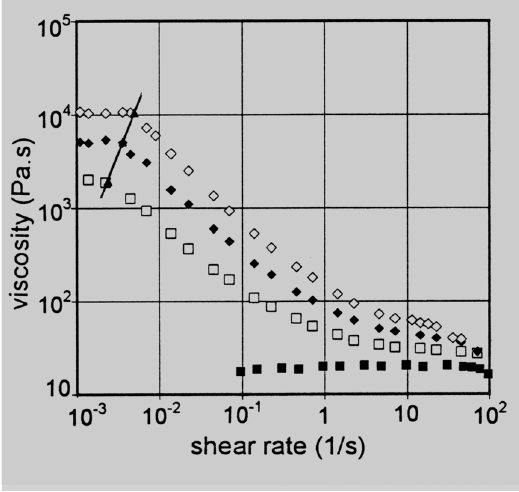
Figure 2 (left above): Viscosity curves of disperse systems with the silicone oil M20000 and different concentrations of Durcal 5 ( · 25%, Ï 32.75%, Ì 40.5%; Ú onset of shear thinning) and of silicone oil M20000 ( ‡ ). Figure 3 (right above): Normal stress curves of suspensions with the sili- cone oil M 20000 and different concentrations of Cab-o-sil TS 720 ( ‡ 1%, · 3%, Ï 5%, Ì 7%) and silicone oil M20000 ( Ú ). Figure 4 (right below): Normal stress curves of disperse systems with the silicone oil M20000 and different concentrations of Durcal 5 ( · 25%, Ï 32.75%, Ì 40.5%) and of silicone oil M20000 ( ‡